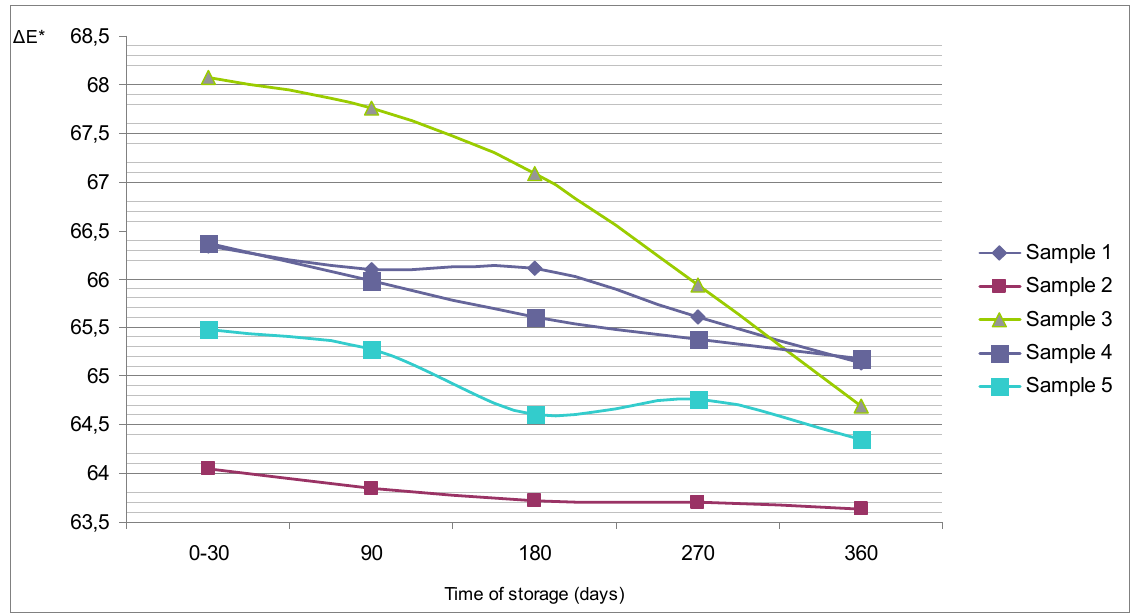
Figure 9. Changes of color difference ( Δ E) on the bottom surface of samples of dietary chocolates during storage of 360 days.